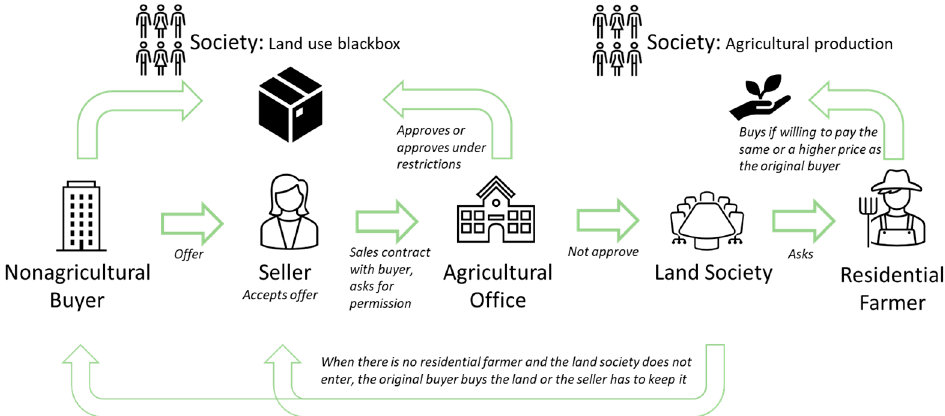
Figure 1. Example farmland transaction under German land transaction law.